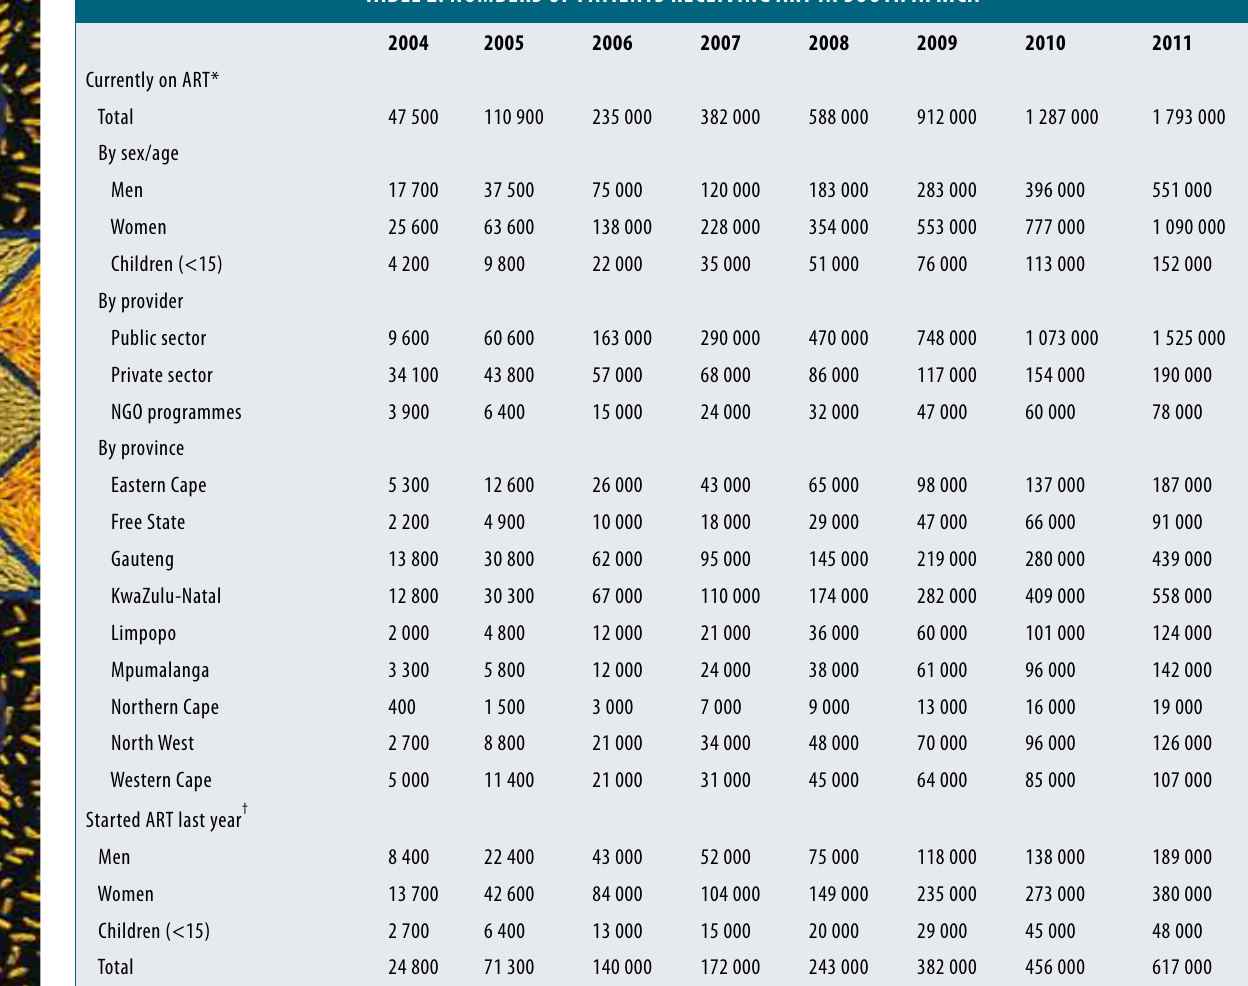
TABLE 2. NuMBERs OF pATIENTs RECEIVING ART IN sOuTh AFRICA